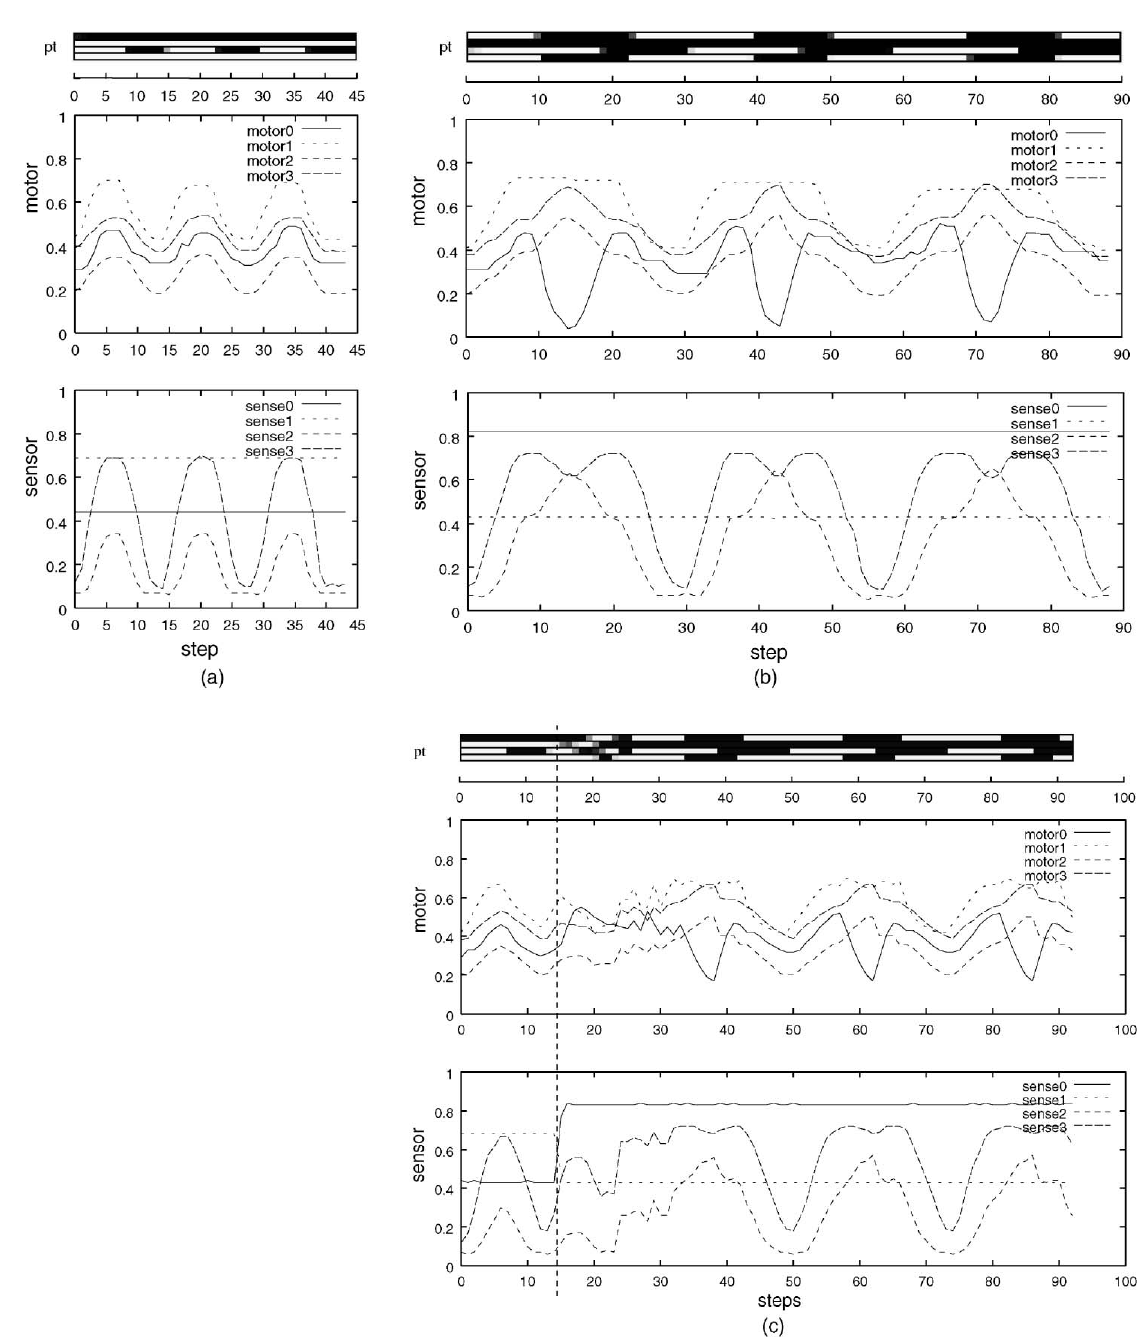
Figure 8. Profiles of task-A and task-B are shown in (a) and (b), respectively . ( c ) shows the profile of the dynamic switching from task-A to task-B, where a dotted line indicates the moment when the object is moved from the center to the left-hand